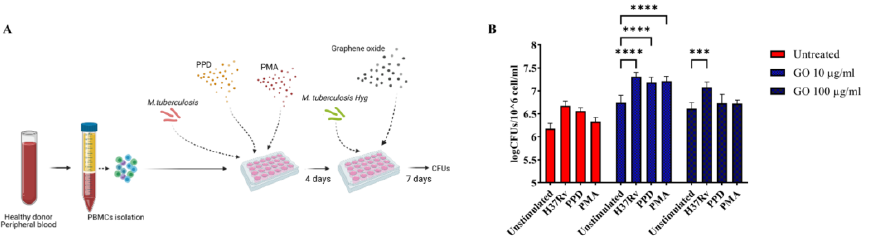
Figure 6. Graphene Oxide toxicity affects not only undifferentiated cells, but also mature macro- phages. Graphene Oxide effect on Mycobacterium tuberculosis survival was evaluated in ex vivo